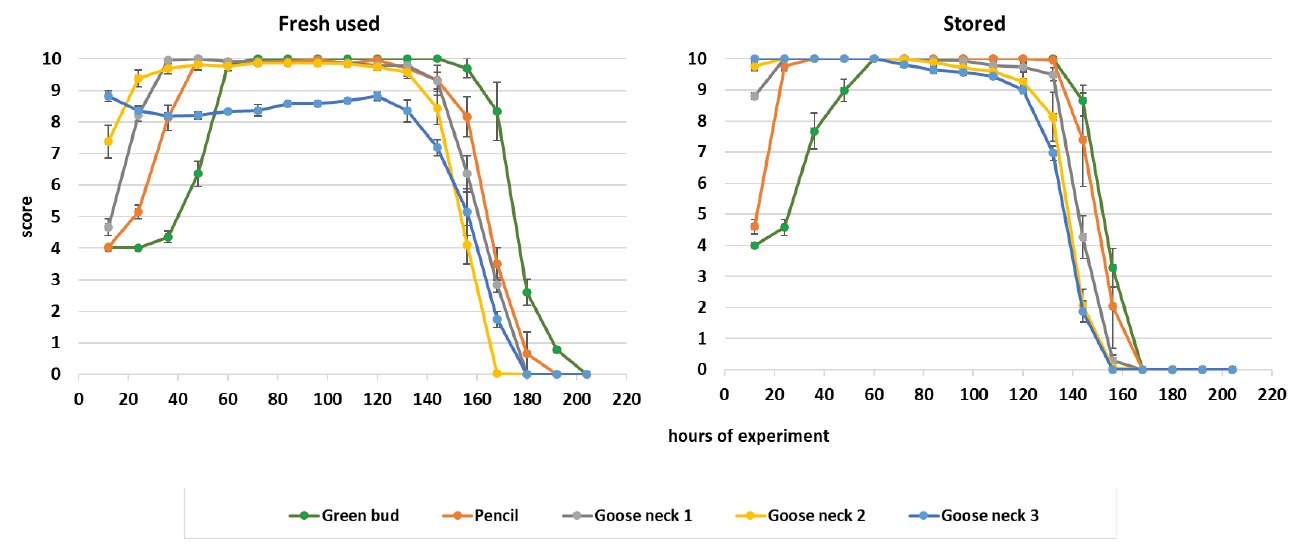
Figure 8. The course of changes of ornamental value based on the point scoring system. Bud stages: green bud (GB); pencil: white bud, upright (PE); goose neck 1: white bud, skew (GN1); goose neck 2: white bud, horizontal (GN2); goose neck 3: big white bud, horizontal, maximum with 1 opening petal (GN3). Table 3. Time to reach the selected values of ornamental value during the flower opening phase.